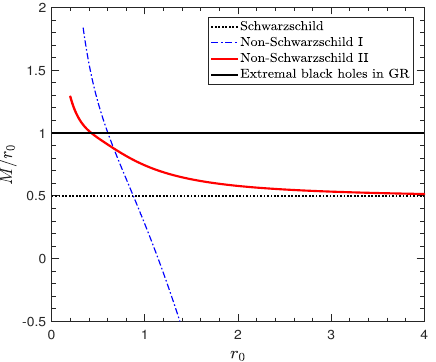
Figure 4 . Mass-to-size ratio M/r 0 of the two branches of non-Schwarzschild black holes as functions of r 0 . Curves are marked in the same style as in figure 3.